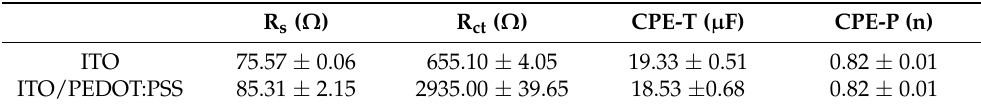
Table 5. Cathodic and anodic peak currents obtained from CV used to study the effect of PEDOT:PSS interlayer.